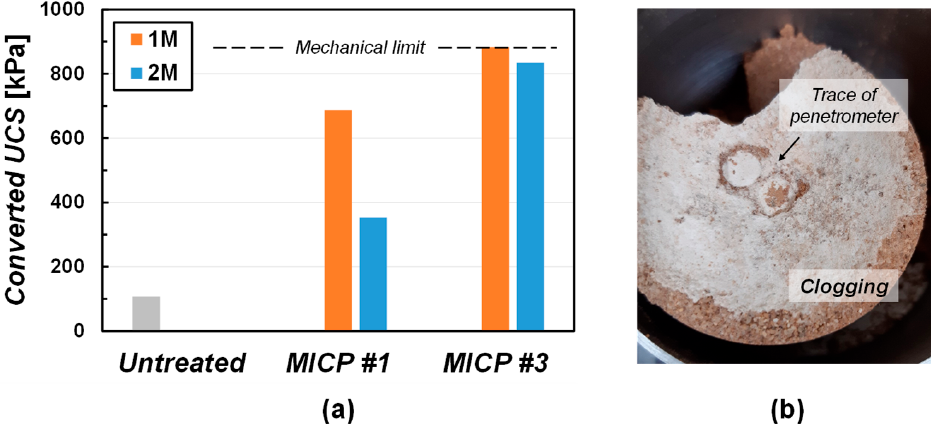
Figure 6. ( a ) Converted UCS from pocket penetrometer measurement and ( b ) cemented surface of the specimen treated by 1 M MICP solution three times. the specimen treated by 1 M MICP solution three